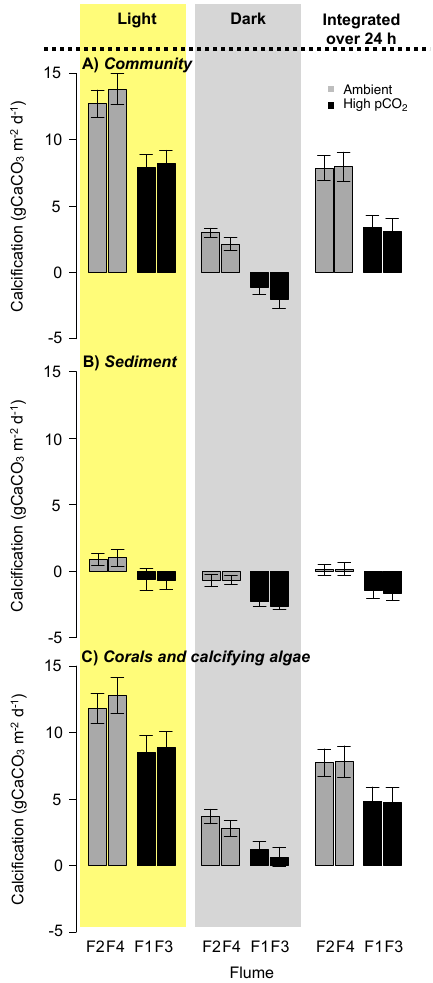
Figure 2. Calcification in the light, dark, and integrated over 24h for intact communities (a) , sediment (b) , and corals and coralline algae (c) maintained under ambient and high p CO 2 ( ∼ 1300µatm). The grey bars represent the calcification measured in the ambient conditions, and the black bars are calcification in the elevated p CO 2 treatment. F1, F2, F3, and F4 indicate the different